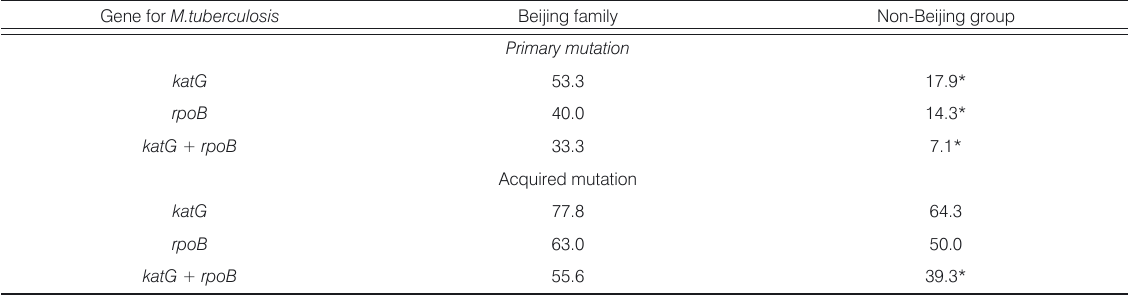
Table 1. Spreading of mutations in rpoB, katG genes for M.tuberculosis (%).